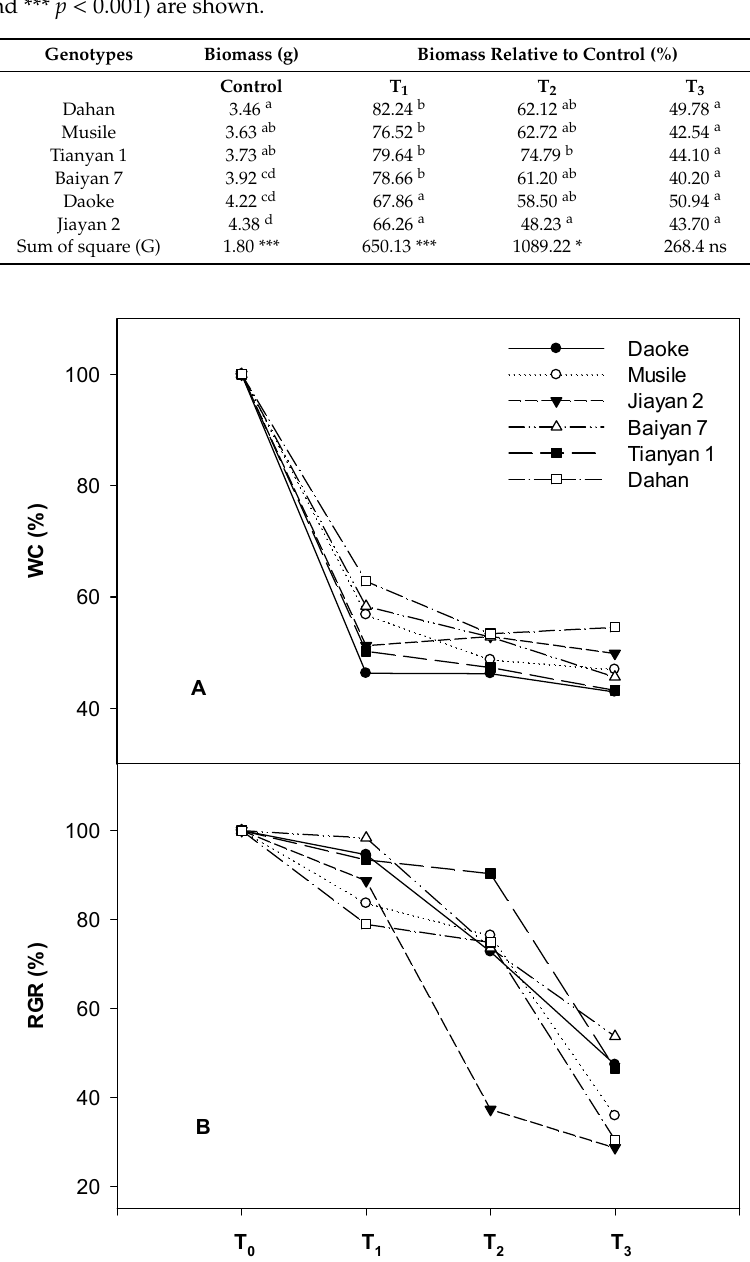
Figure 1. Relative decrease in water content (WC) ( A ) and growth rate (RGR) ( B ) of six different oat genotypes under different salinity concentrations compared to control conditions. T 0 (Control, normal Hoagland solution); T 1 (Hoagland solution with additional NaCl, EC at 8 dS m − 1 ); T 2 (Hoagland solution with additional NaCl, EC at 16 dS m − 1 ); T 3 (Hoagland solution with additional NaCl, EC at 24 dS m − 1 ).